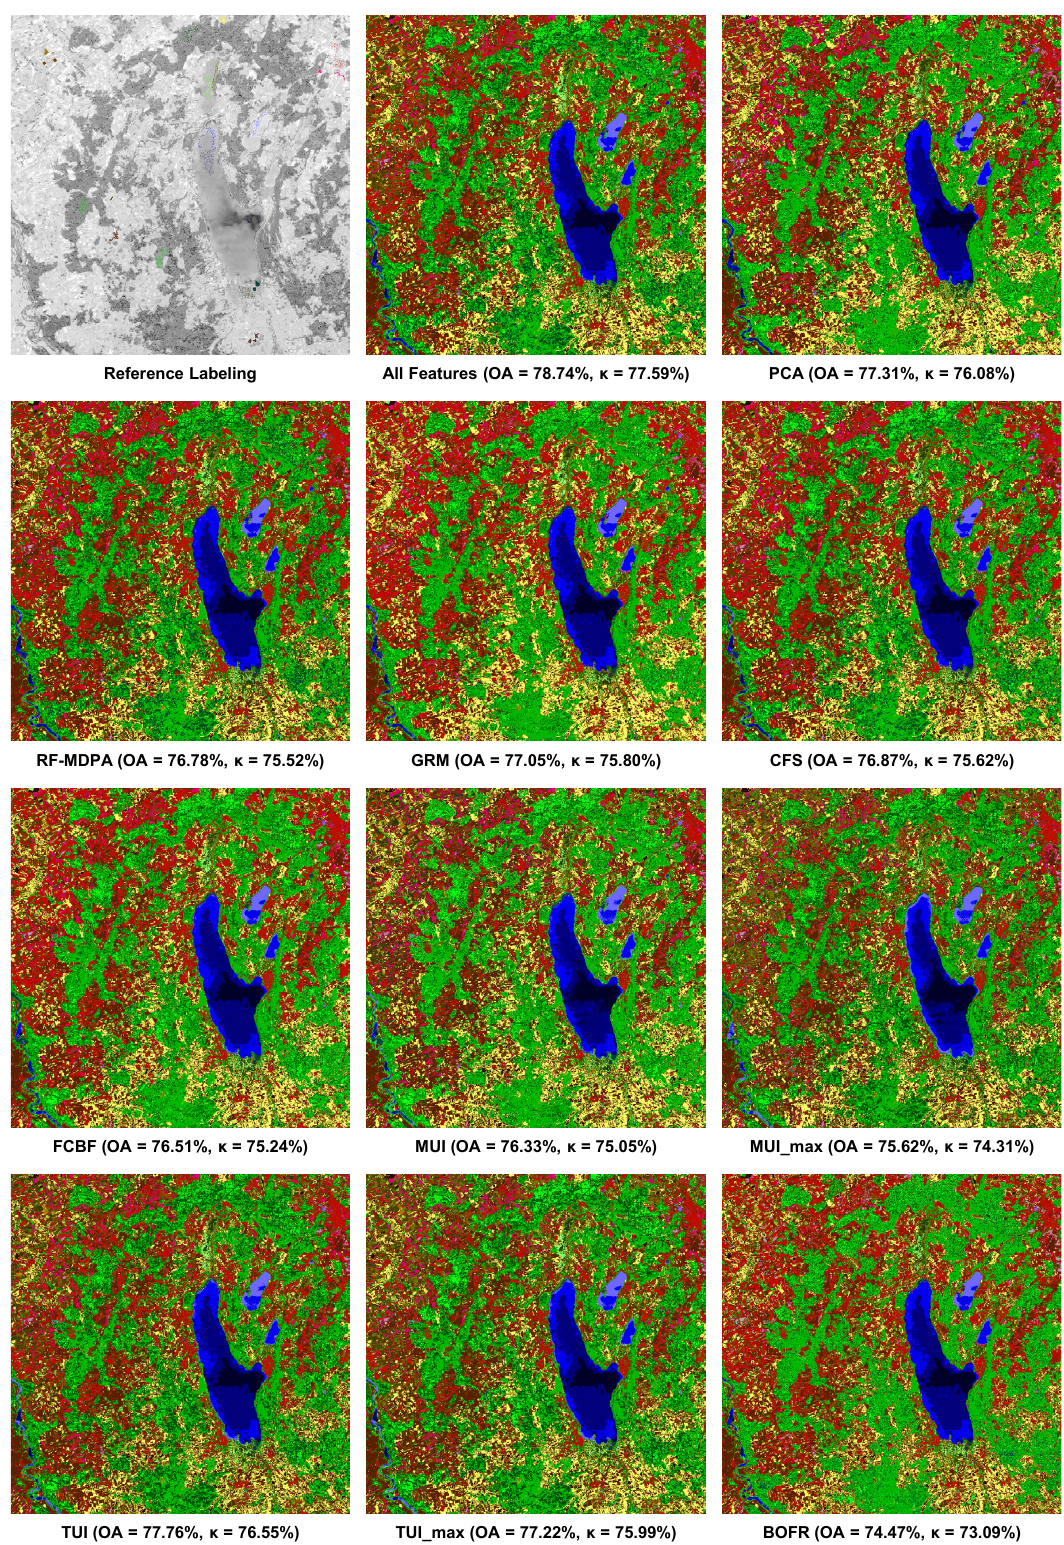
Figure 13. Classified scene for the EnMAP dataset when using the RF classifier and different feature sets. The values in brackets refer to the evaluation on the test